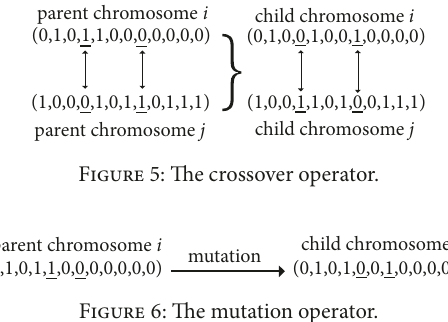
Figure 6: The mutation